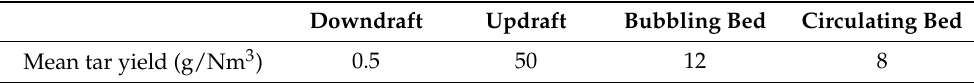
Table 4. Tar yield according to the type of gasifier